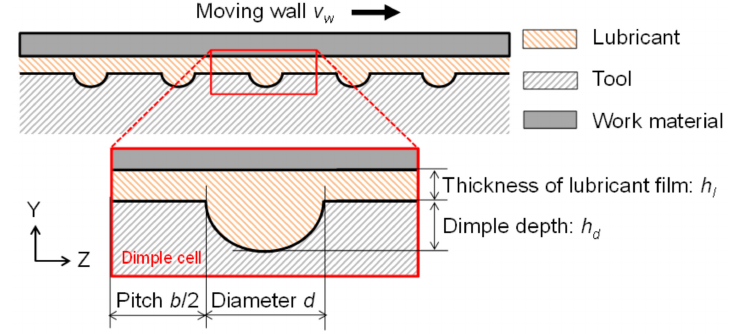
Figure 4. Schematic illustration of the model of micro dimple cells for the CFD (computational fluid dynamics)